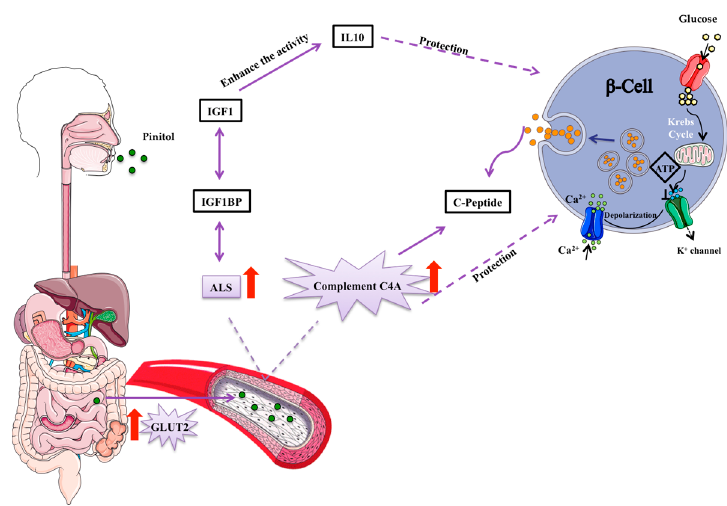
Figure 6. Suggested mechanism of pinitol-induced effects on the insulin secretion pathway. Pinitol is a glucose mimetic molecule, which is absorbed in the small intestine and distributed though the bloodstream to the whole organism. An increase in the acid labile subunit (ALS) and C4A complement proteins induce a protection of β -cells. Pro-preinsulin granules are packed inside pancreatic β -cells and secreted outside the cell as insulin, in response to nutrient intake.